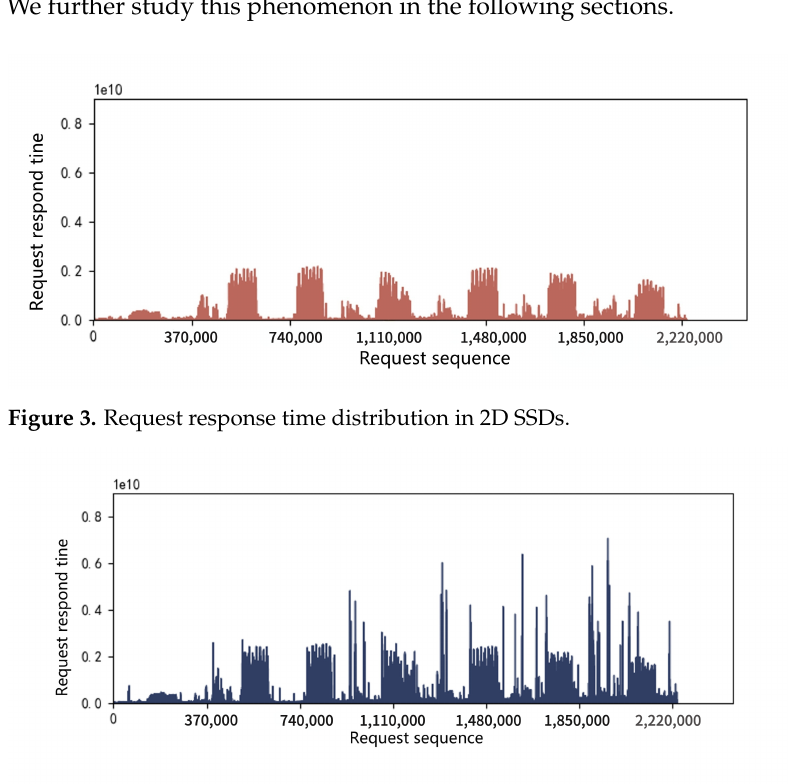
Figure 4. Request response time distribution in 3D SSDs.The performance cliff phenomenon of 3D SSDs is much more serious than that of 2D, which is manifested in a sudden high latency as shown in the